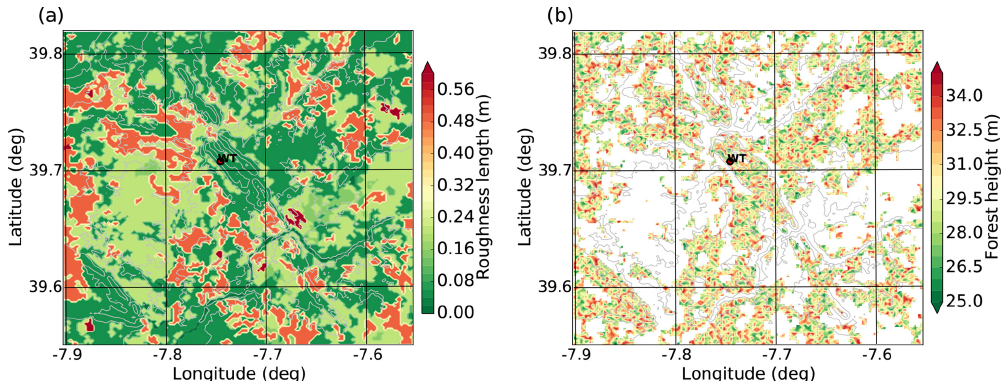
Figure 2. Surface roughness length of (a) the CORINE data set and (b) tree heights of the additionally implemented forest friction term applied to domain D3. White areas are not covered by forest. The location of the WT is marked with the red dot and the topography is indicated with grey contour